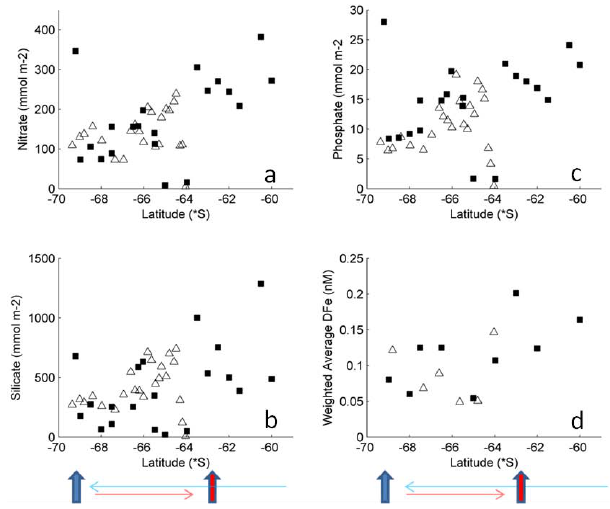
Fig. 6. Removal of nitrate (a) , silicate (b) , phosphate (c) and weighted average DFe (d) against latitude for the Weddell Sea tran- sect (open triangles), and the Greenwich Meridian transect (filled squares) (Klunder et al., 2011a). Nutrients data is available for more stations than DFe data, hence more data points. Location of the shelf (500m depth isobaths) is marked for the Greenwich Meridian tran- sect (blue vertical arrow) and the Weddell Sea transect (red vertical arrow). Horizontal light arrows (blue and red) indicate the direction of the ship along the transect. (Please notice that the Greenwich Meridian transect is oriented north-south, and the Weddell transect is oriented from southeast to Northwest (see Fig.